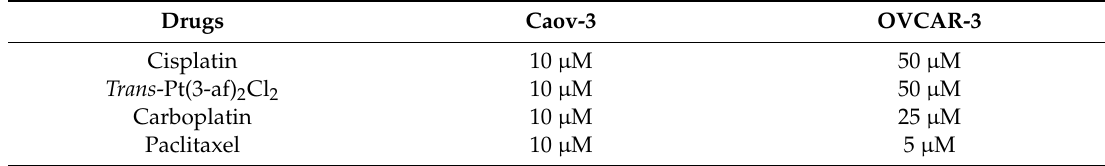
Table 4. IC 50 values of the investigational medicinal